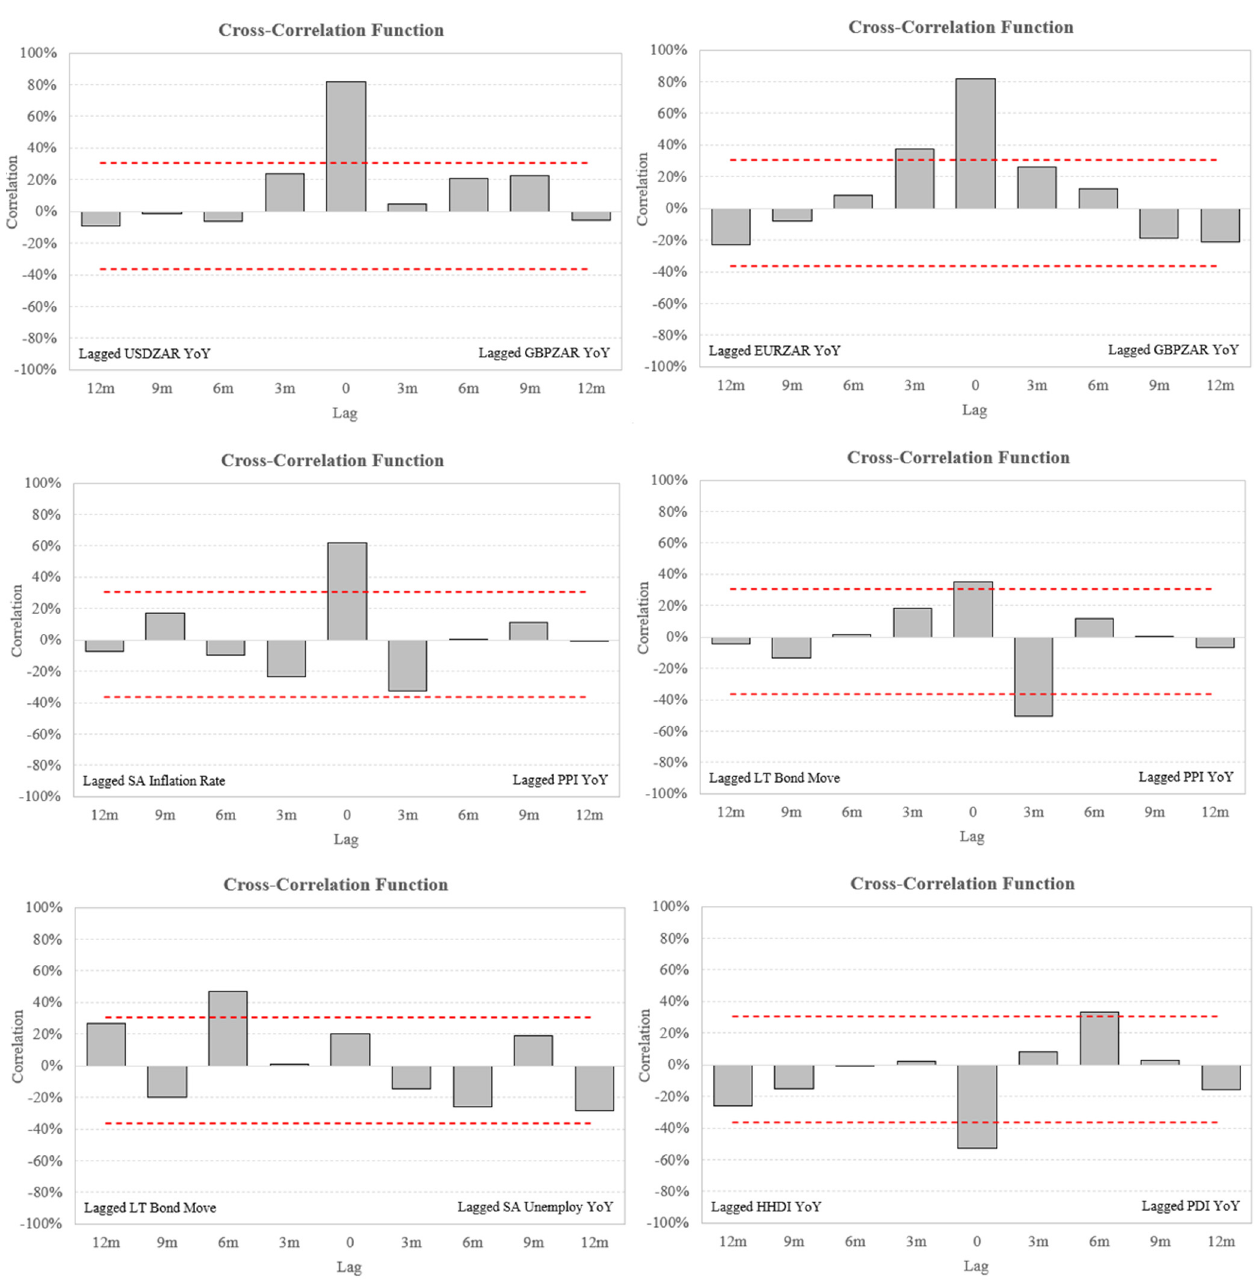
Figure 2. Cross-correlation graphs between selected variable pairs based on quarterly historical data from March 2010 to December 2018.